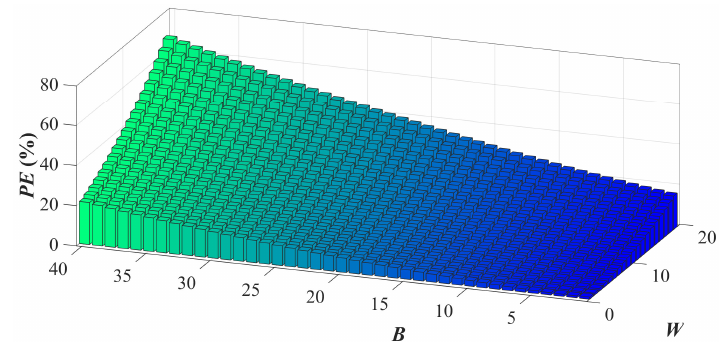
Figure 11. Probabilistic assessment. Mean PE across the M cases for different values of W and B